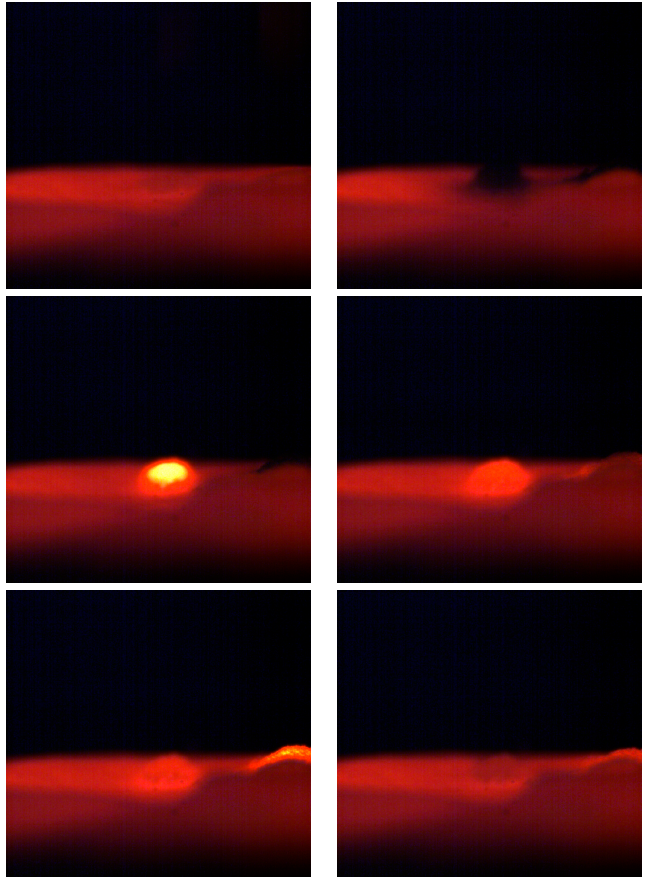
Figure 25. Ignition sequence (left to right, top to bottom) for 10 µm Al powder falling onto Ni-chrome ribbon at approximately 1200 °C. The total time from falling on the foil until achieving equilbrium with the foil is about 0.04 s.